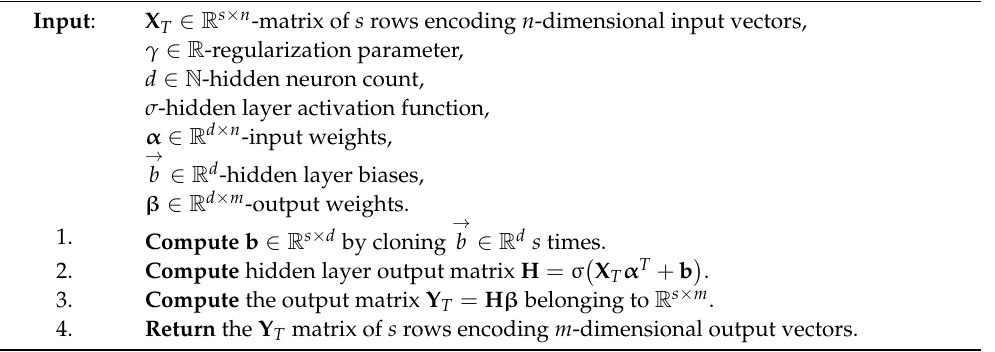
Algorithm 4 Extreme learning machine